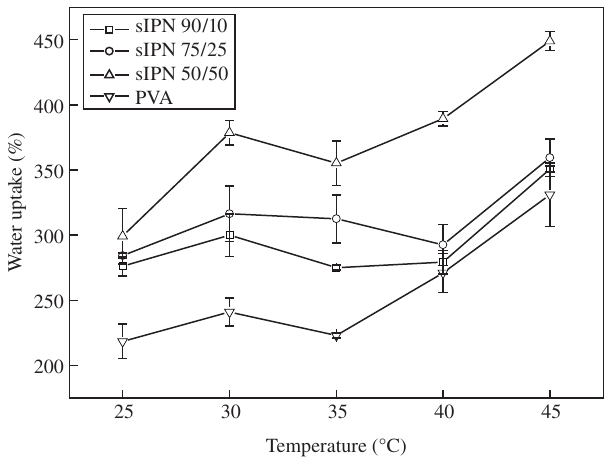
Figure 3. Equilibrium water uptake (WU) of the s-IPN PVA/PES hydrogels as a function of temperature.